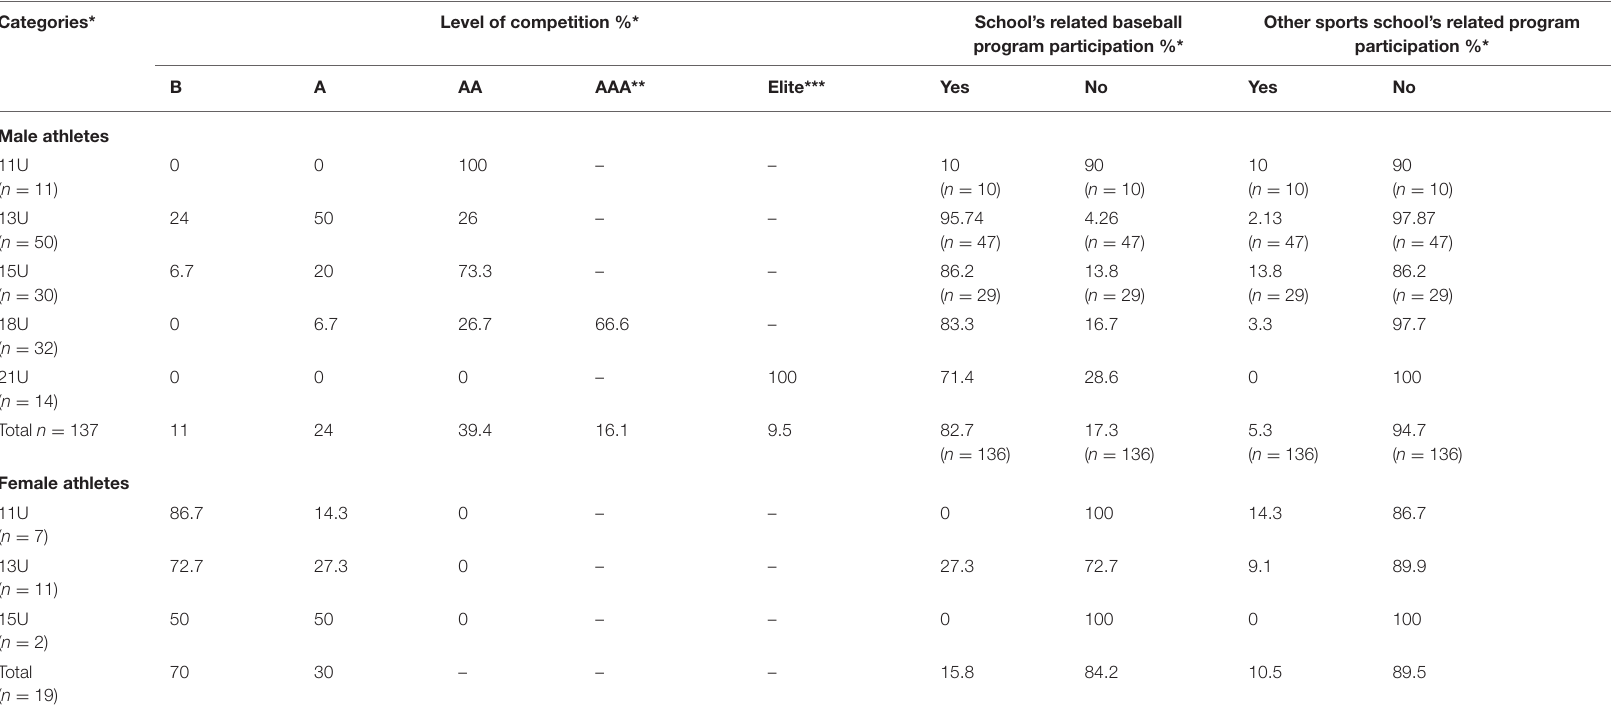
TABLE 2 | Competitive levels of male and female athletes and school-related sports